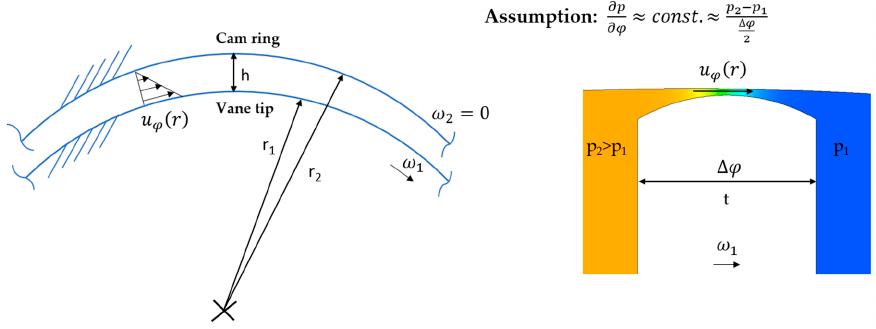
Figure 4. Simplified model 1 to obtain an analytical solution for u ϕ ( r ) in the radial gap.